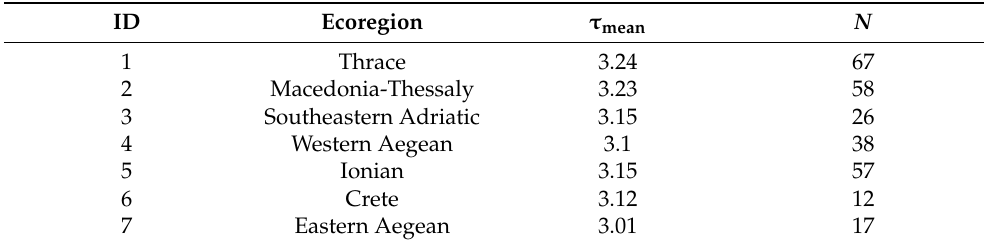
Table 1. Mean trophic level ( τ mean ) values and the total number of species ( N ) of each Greek ecoregion, named according to Zogaris and Economou